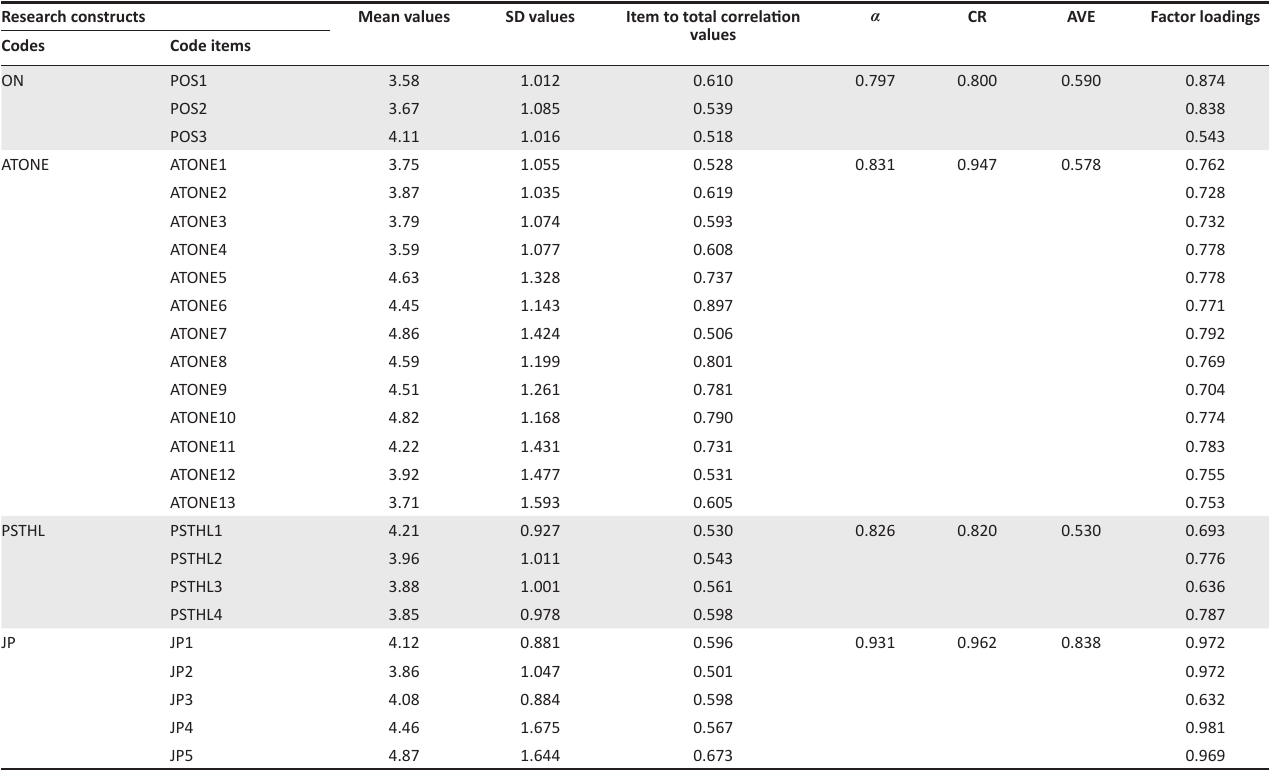
TABLE 2: Scale accuracy